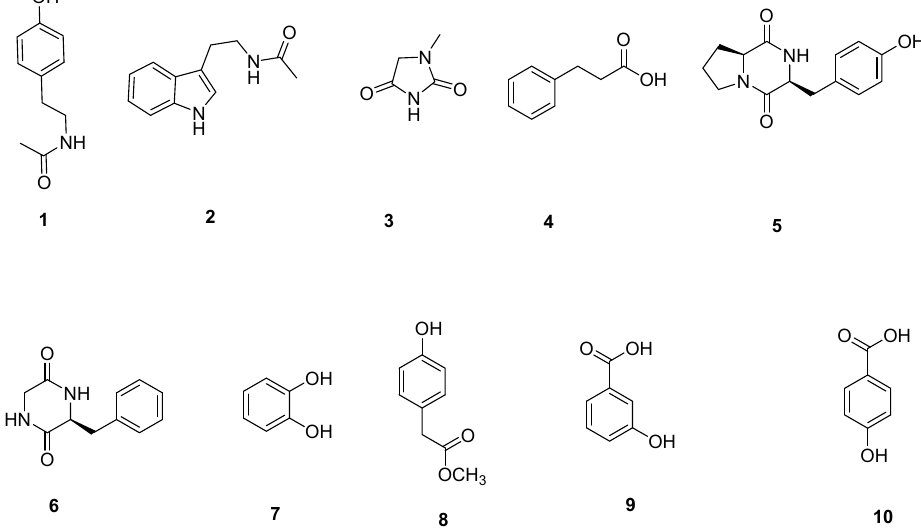
Figure 4. The compounds 1 – 10 isolated from Micromonospora sp. WH06.